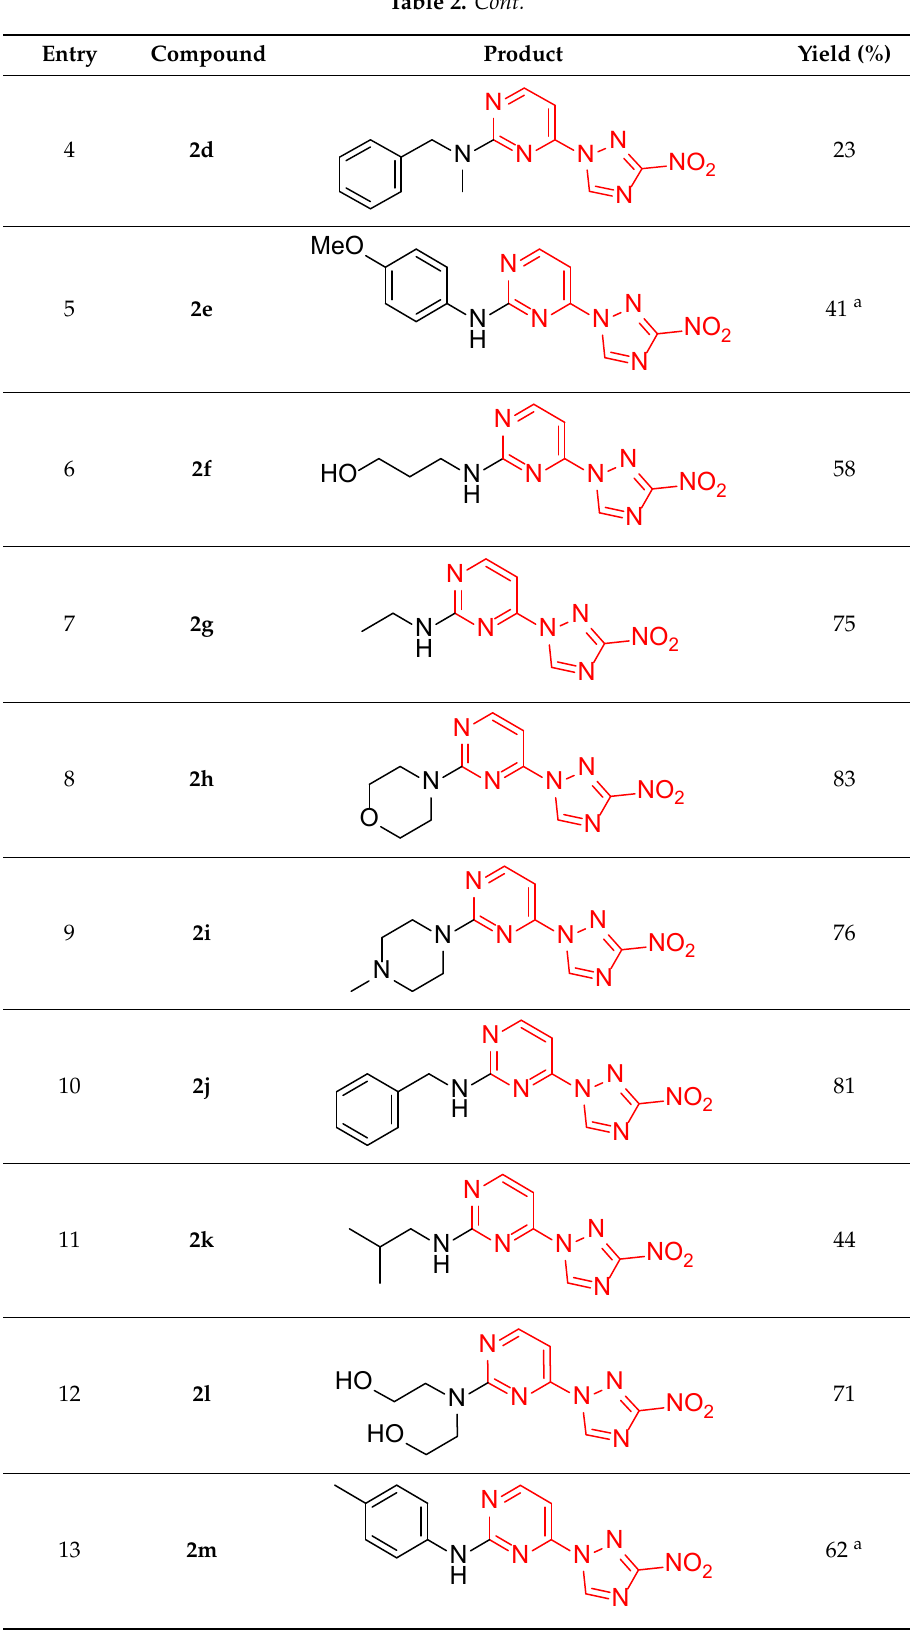
Table 2. Synthesis of 4-(3-nitro-1,2,4-triazol-1-yl)pyrimidines 2a-s .